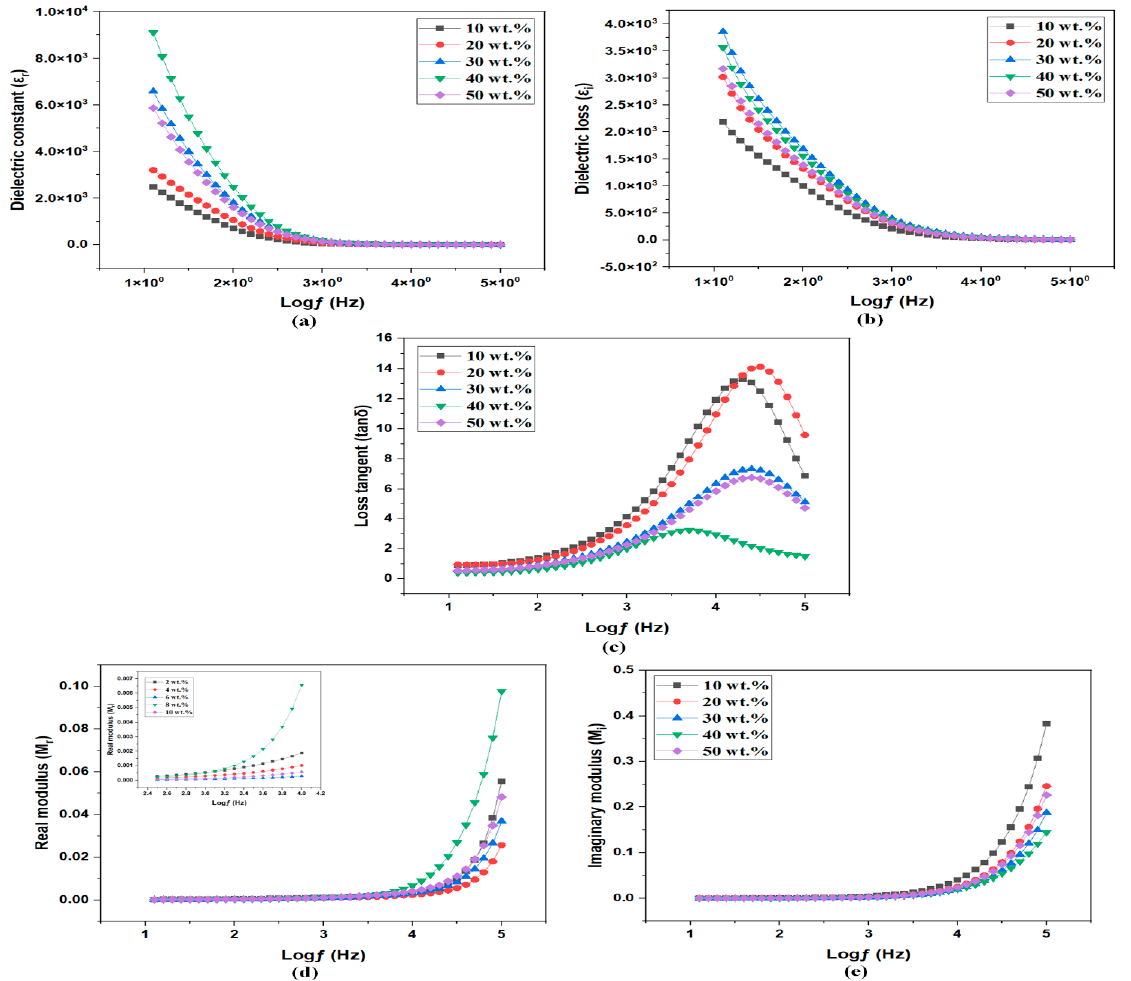
Figure 7. Dielectric spectra of MC/PC/NH 4 Cl films; ( a ) Real part of complex permittivity ( b ) Imaginary part of complex permittivity ( c ) Loss tangent ( d ) Real part of complex modulus ( e ) Imaginary part of complex modulus.